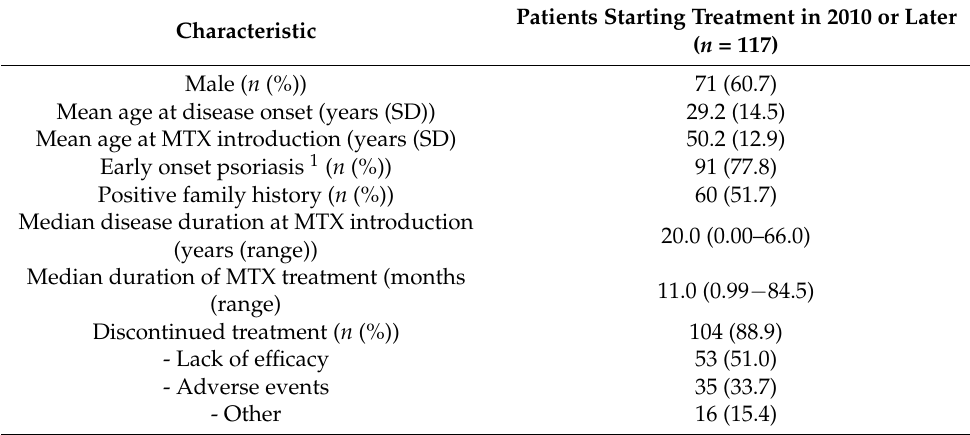
Table 2. Patient and treatment characteristics of the subpopulation of patients with methotrexate introduction in 2010 or later.